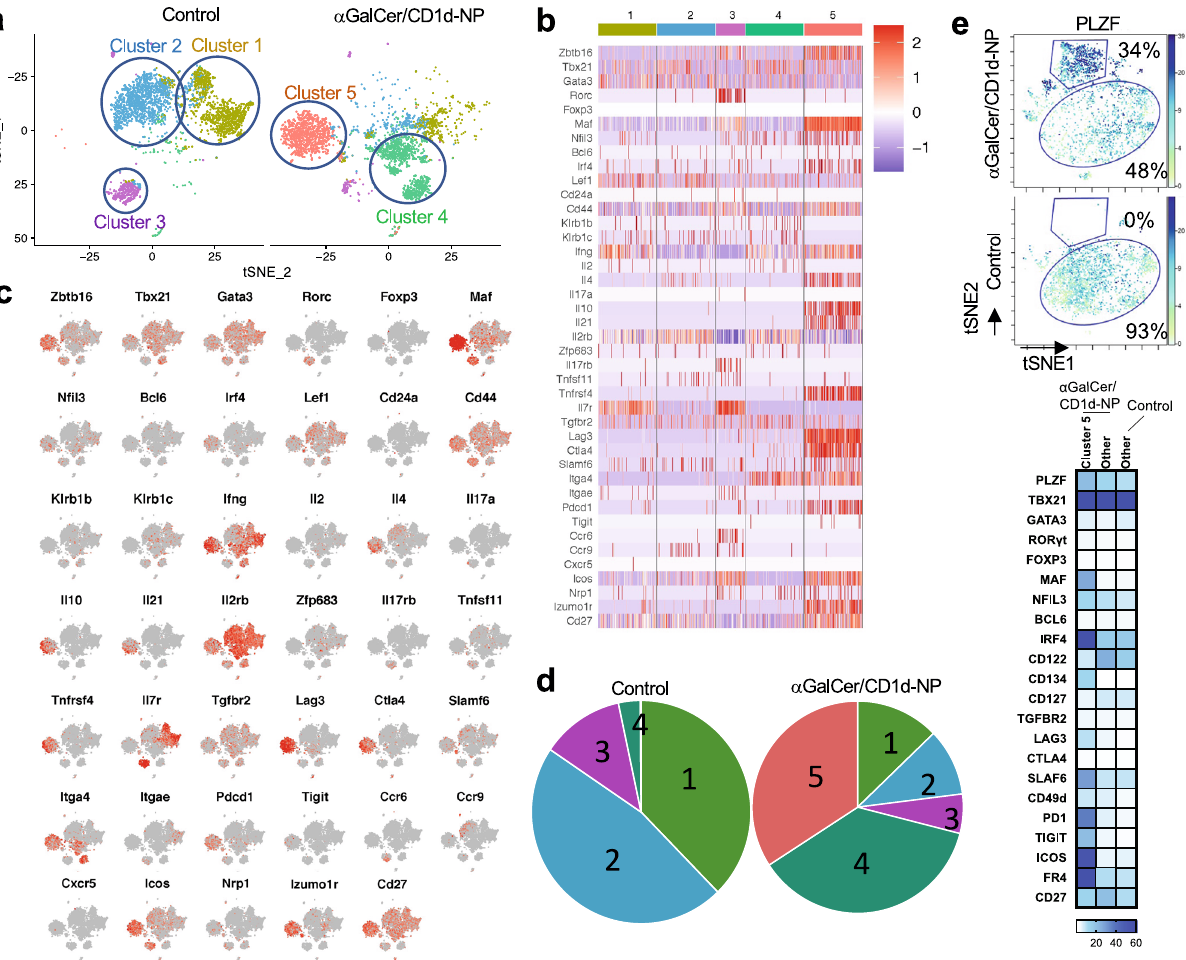
Fig. 4 Single-cell RNAseq and mass cytometry of LiNKT cells in untreated vs α GalCer/CD1d-NP-treated mice. a tSNE plots from α GalCer/CD1d tetramer + cells from the livers of two untreated (left) and two treated NOD. c3c4 mice (right). Data for each individual mouse in each group were similar. Note how α GalCer/CD1d-NP therapy triggers a reduction in the size of clusters #1, #2, and #3, an increase in the size of cluster #4 and the de novo appearance of LiNKTR1 cells (Cluster #5). b Heatmaps comparing expression levels for the genes from Table 1 in the 5 liver iNKT cell clusters identi fi ed in untreated and/or α GalCer/CD1d-NP-treated mice. c Feature maps showing the location of gene expression for the genes from Table 1 and the combined cell clusters of untreated and treated mice (from a ). d Pie charts depicting changes in the prevalence of the 5 LiNKT cell clusters in control vs. treated mice. e Cluster analyses of α GalCer/CD1d tetramer + cells from the livers of three untreated and three treated NOD mice, upon staining with 22 metal-labeled antibodies and analysis via mass cytometry. Top panel shows a representative tSNE plot (for PLZF), indicating the position of the cluster 5 identi fi ed via scRNAseq (arising in response to α GalCer/CD1d-NP-treatment) and the iNKT cell pool comprising clusters 1 – 4 found in both treated and control mice (subpools cannot be resolved via CyTOF). Bottom panel, expression heatmaps for each marker in the LiNKTR1 scRNAseq cluster 5 vs. other LiNKT cells in treated mice (left, middle) and the LiNKT cells found in control mice (right). Data in a – e were generated using cells isolated 2 – 3 days after the last α GalCer/CD1d-NP